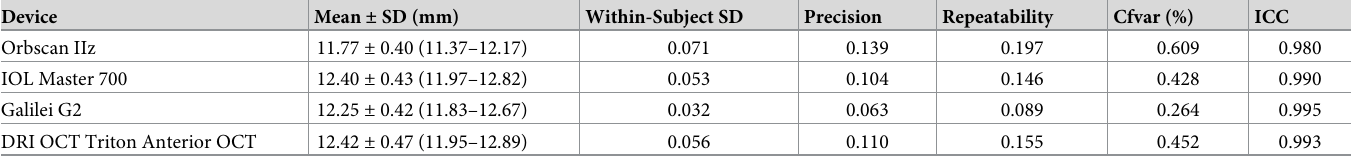
Table 1. Intra-observer repeatability of white-to-white/horizontal internal anterior chamber diameter in control subjects using the Orbscan IIz, IOL Master 700, Galilei G2 and DRI OCT Triton Anterior OCT. Device